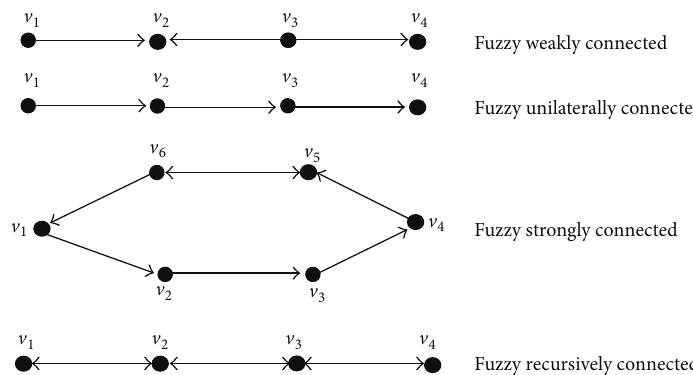
Figure 2: Different kinds of connectivity in a directed fuzzy social